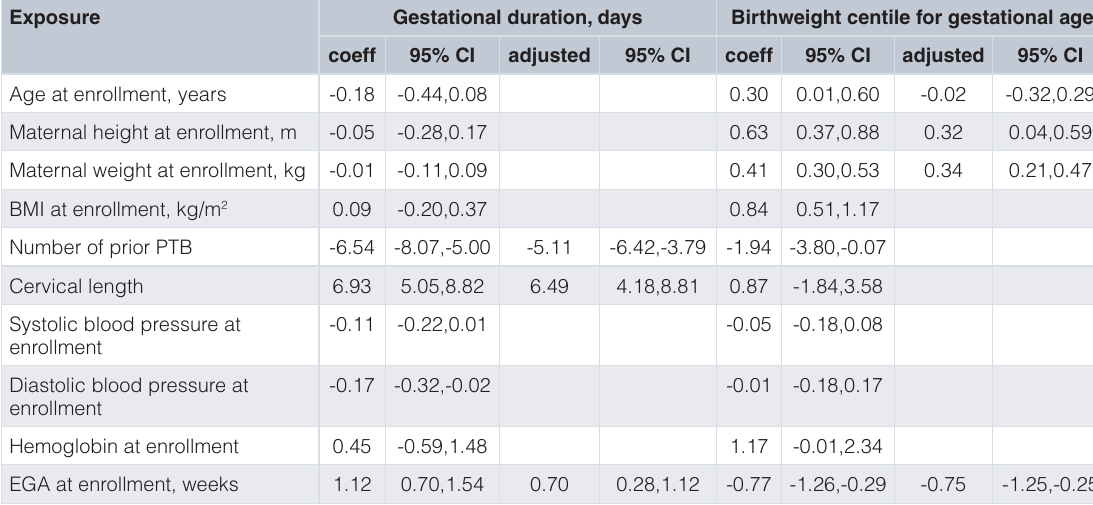
Table 6. Association between continuous exposures by gestational duration and birthweight